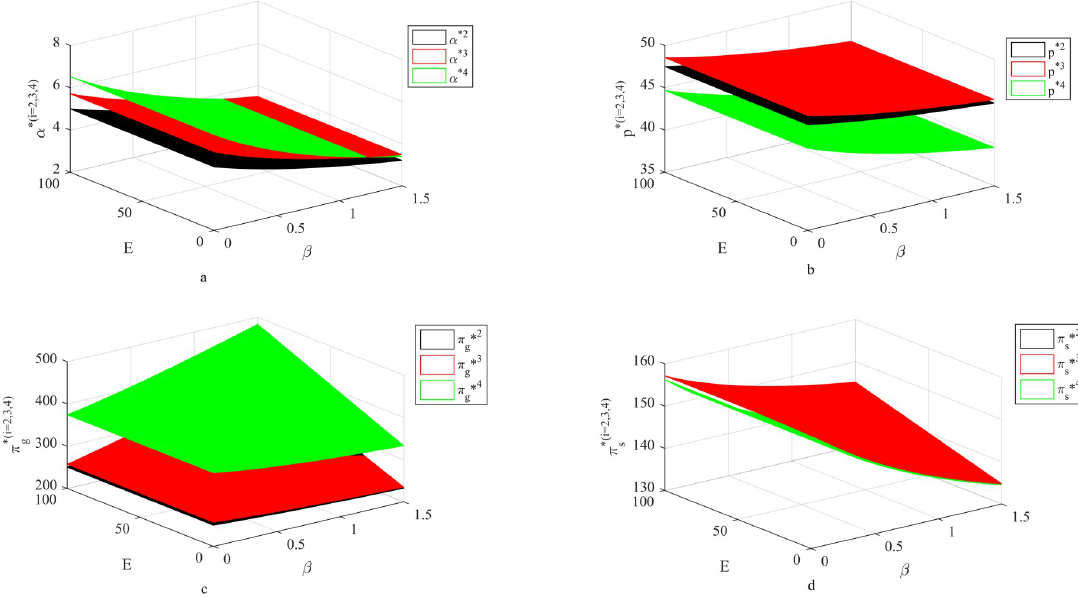
Fig 5. Influence of β , E on fresh-keeping decisions and